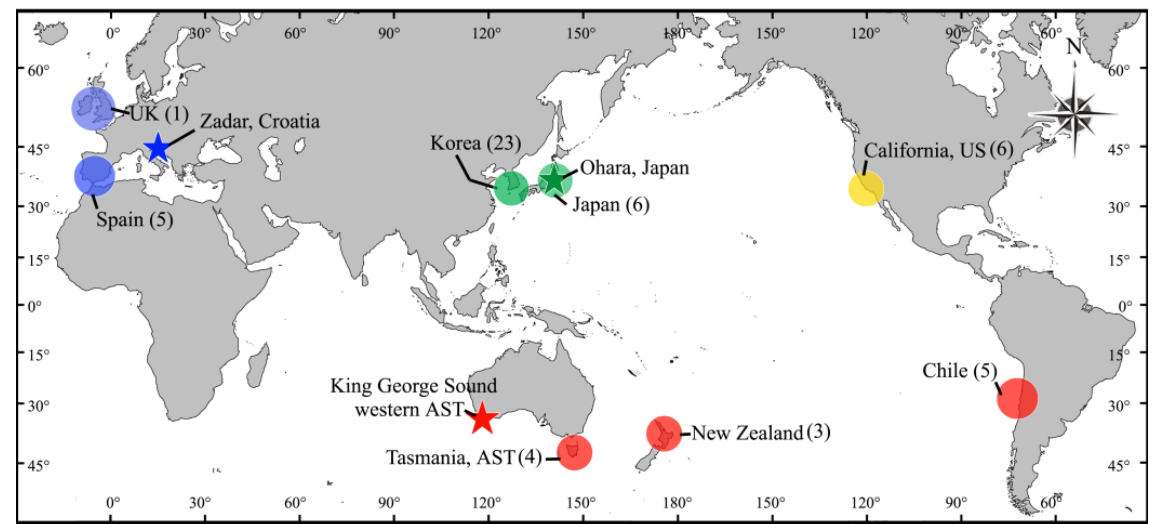
Figure 1. A map showing the sampling locations (circles: blue from Europe; green from NW Pacific; yellow from California; red from southern hemisphere), and type localities for A. venulosum (blue star), A. flabellatum (green star), and A. ciliolatum (red star). Numbers: sample number for molecular analysis.